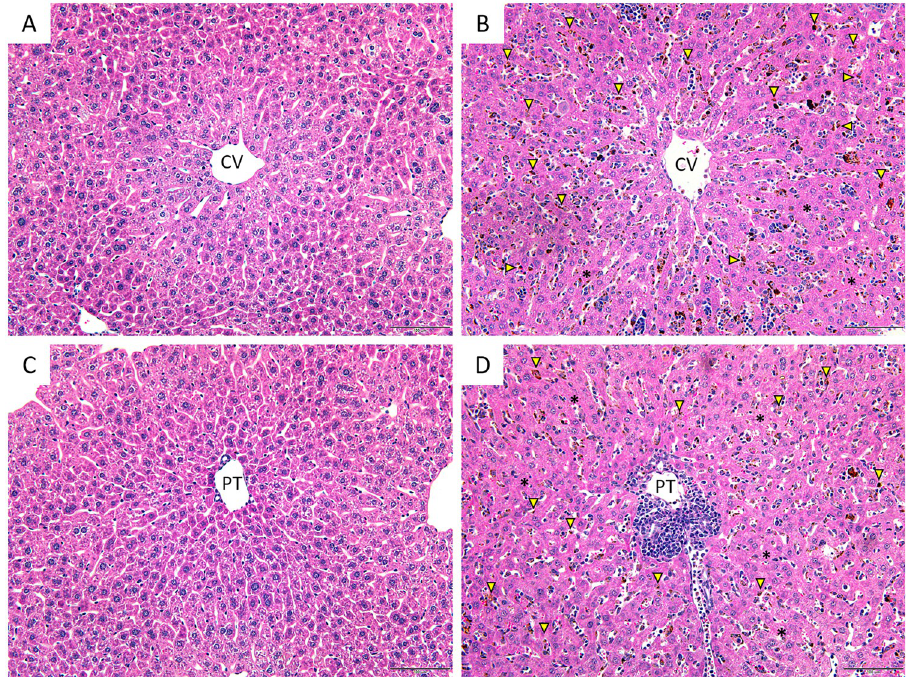
Fig 1. Histopathological changes in liver tissues from control (A) and PbA-infected mice (B). The histomorphological changes in PbA-infected mice include hemozoin deposition (indicated by yellow arrowheads) and apoptotic hepatocytes (indicated by black asterisks) around the central vein. Central vein (CV); Portal tract (PT). All images are shown at 200 × magnification. Scale bar = 100 μ m.